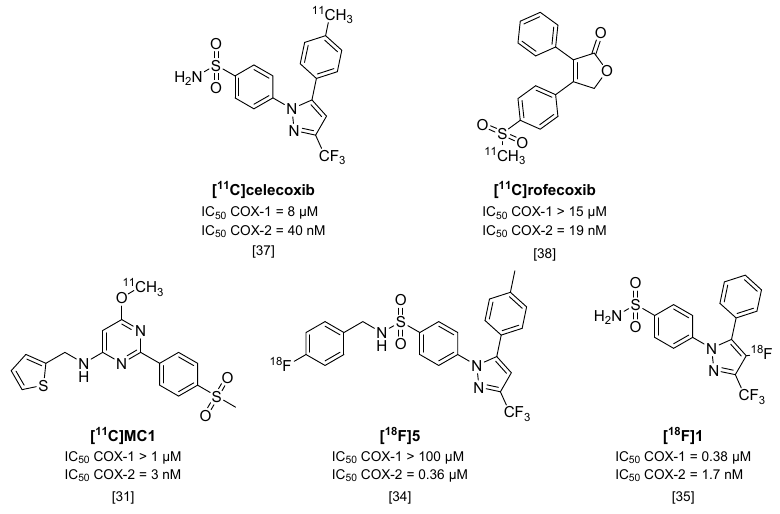
Figure 3. Radiolabeled inhibitors of cyclooxygenase-2 (COX-2).